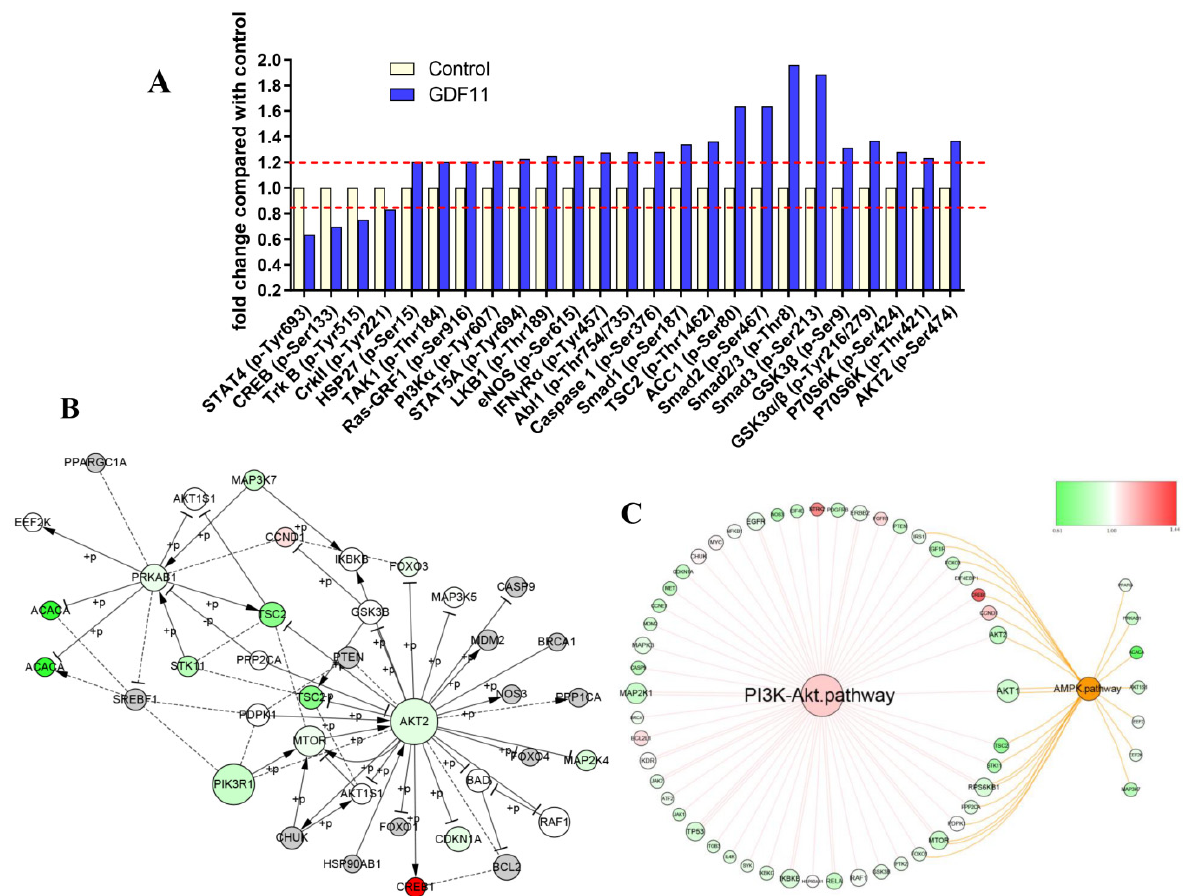
Figure 6. PI3K-Akt pathway was enriched by CSP100 PLUS Microarray. ( A ) Histogram showed the relative fold changes of the differentially expressed proteins when treated with GDF11. The dotted lines were set at ±1.2 and considered as the differentially expressed proteins. ( B ) The core signal-net were conducted by Ingenuity pathway analysis (IPA). ( C ) The key pathway cross-talk analysis was performed by IPA.